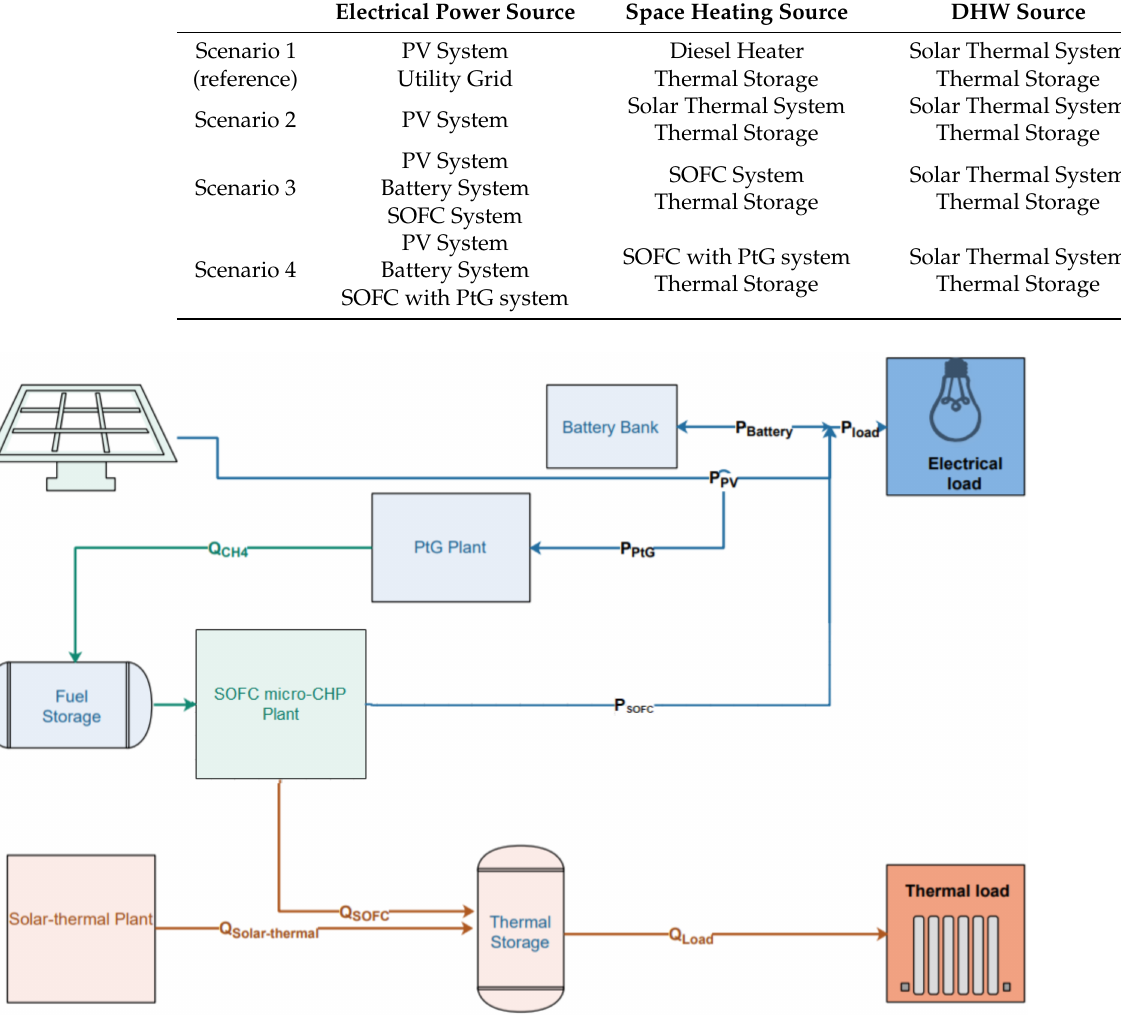
Figure 8. The HPS model with all the integrated components, Scenario